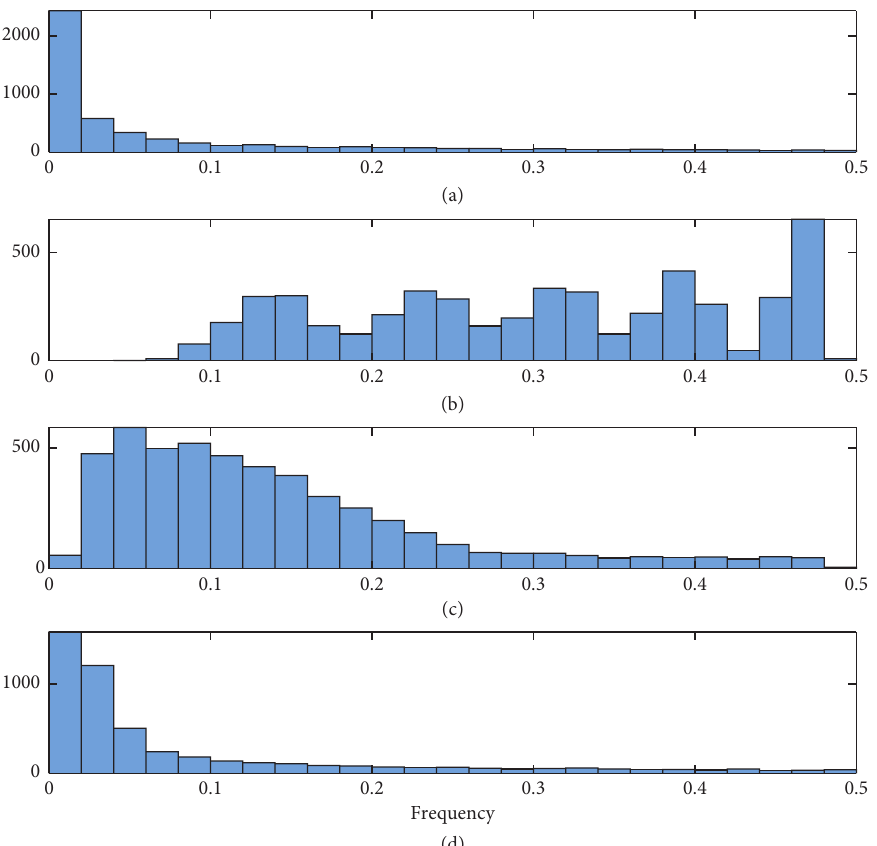
􏼈 􏼉 and the converged center frequencies ω n 􏼈 􏼉 , in the case of three k k